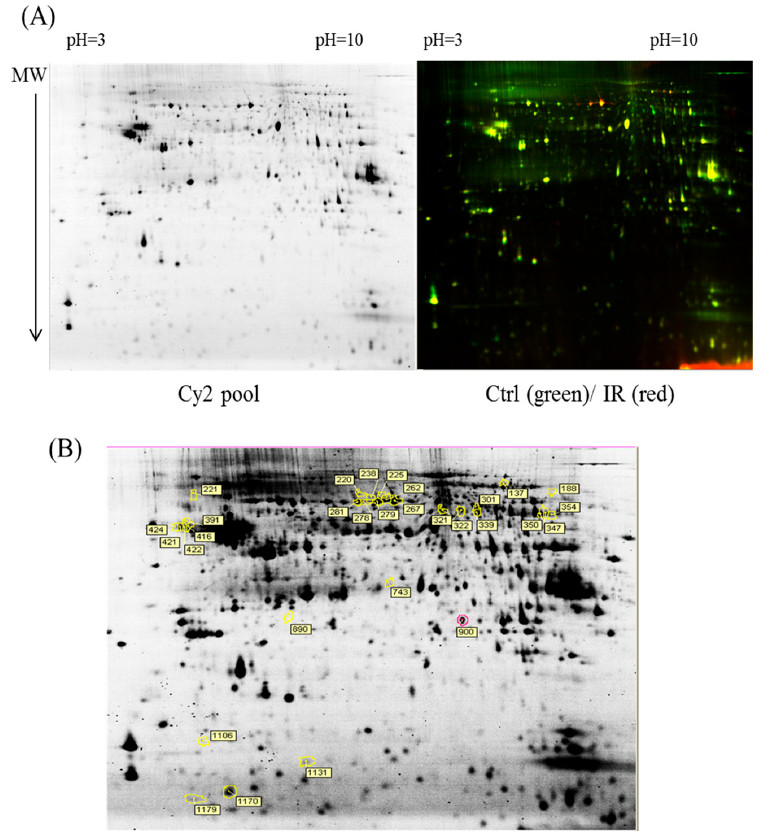
Figure 5. Comparison of proteomics between the IR injury and control groups in retina. ( A ) Schematic representation of the 2D-DIGE workflow for monitoring the differentially expressed proteins in the retina of the IR injury and control groups; ( B ) 2D-DIGE images of the tissue samples analyzed using DeCyder software; the differentially expressed identified protein features are annotated with circles and spot numbers.